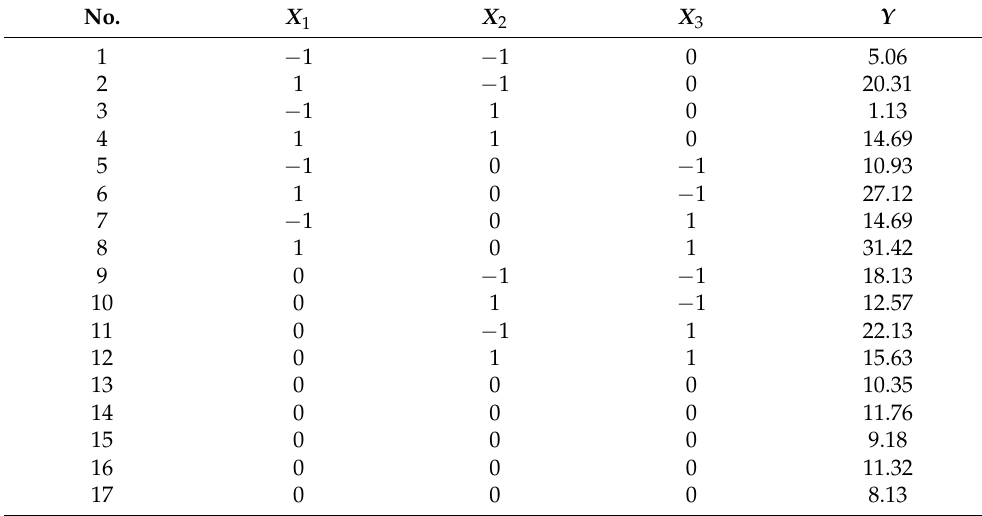
Table 4. Experiment schemes and